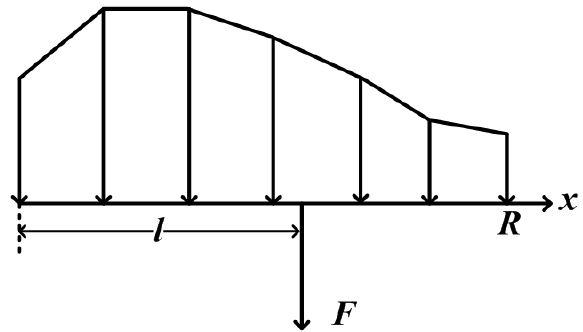
Figure 7 . Force equivalent to distributed